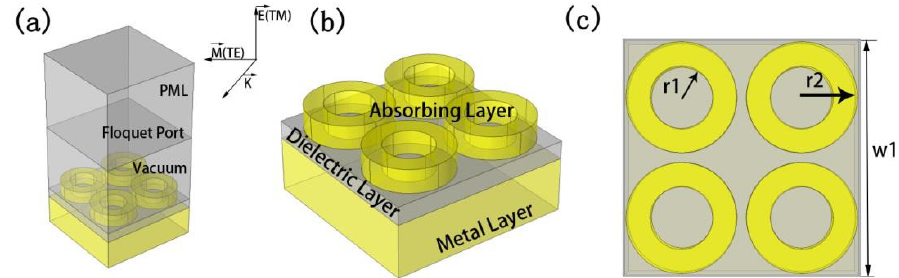
Figure 1. Basic absorber schematic: ( a ) a periodic unit structure of the absorber, ( b ) schematic diagram of the components of the absorber, and ( c ) top view of the absorber.